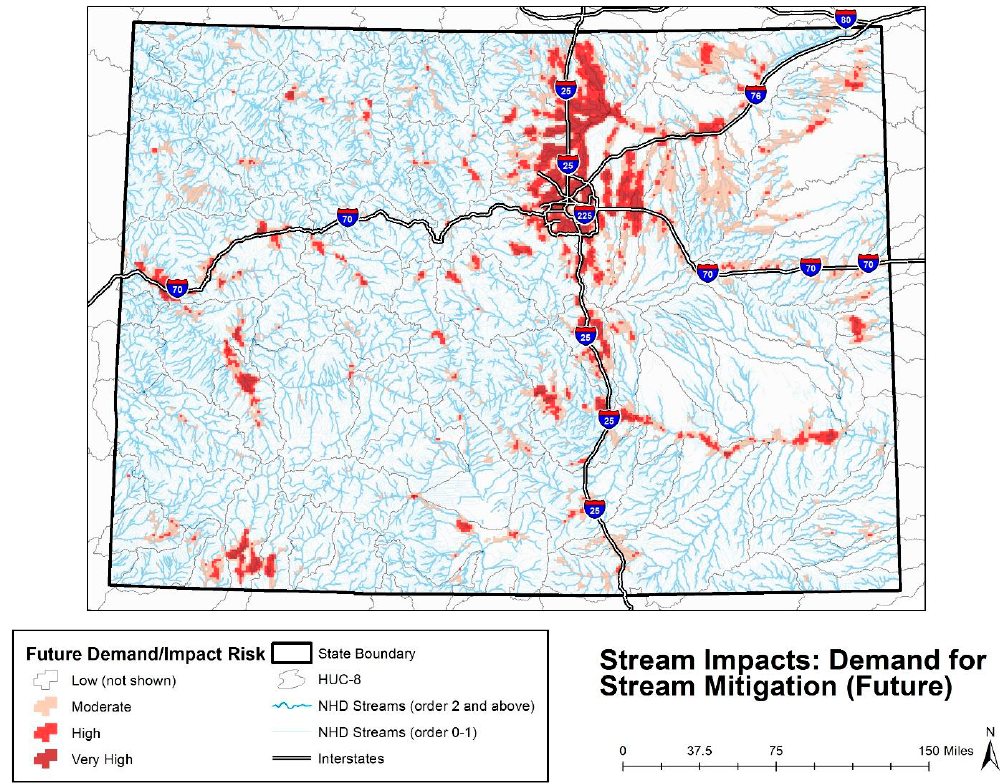
Figure 6. Projected stream impacts/demand for mitigation in Colorado.